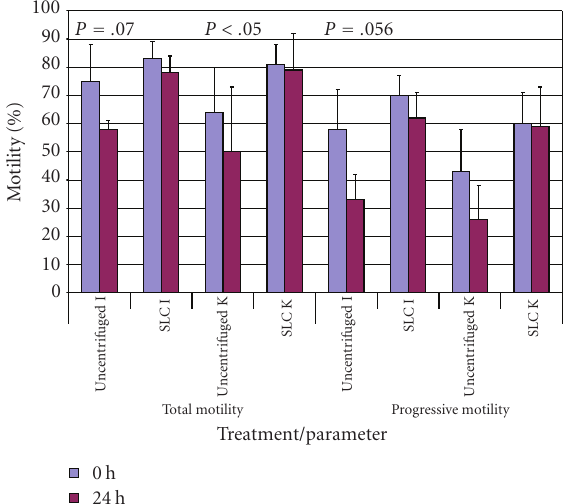
Figure 3: Mean values for total motility (%) and progressive motility (%) for one stallion (Stallion I) ( n = 4). Note: SLC: Single Layer Centrifugation; I: INRA96; K: Kenney’s extender. Significant di ff erences and trends towards significance between 0 hour and 24 hours within each treatment group are shown on the figure. Other significant di ff erences were found as follows: for progressive motility between K uncentrifuged and K SLC at 24 hours ( P < . 05), between I uncentrifuged and I SLC at 24 hours ( P < . 001), and between K SLC and I SLC at 0 hour ( P < . 05); for total motility, between K uncentrifuged and K SLC at 24 hours ( P < . 05), and between I uncentrifuged and I SLC at 24 hours ( P < . 01). There were no di ff erences between ejaculates except for total motility, uncentrifuged, I versus K at 0 hour.